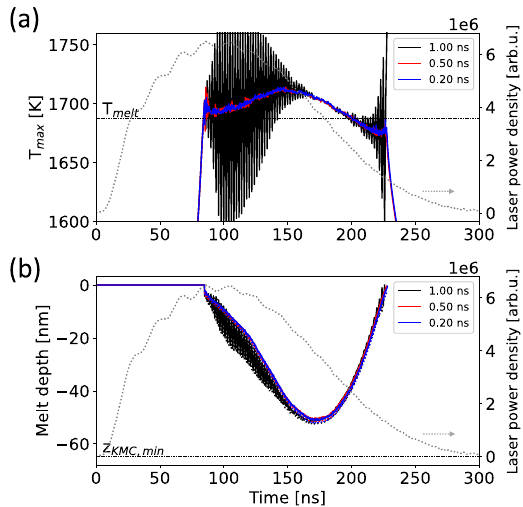
Fig. 7 Sensitivity of LA simulations to FEM-KMC cycle time interval. a Maximum T value in the FEM mesh plotted as a function of time in a range of T close to T M , for three different values of Δ t , namely 0.2 (blue), 0.5 (red), and 1 ns (black), using a fl uence of 2.1 J cm − 2 . The power density of the laser pulse over time is also shown as black dotted line. b Pro fi le of melt-depth over time for the same Δ t